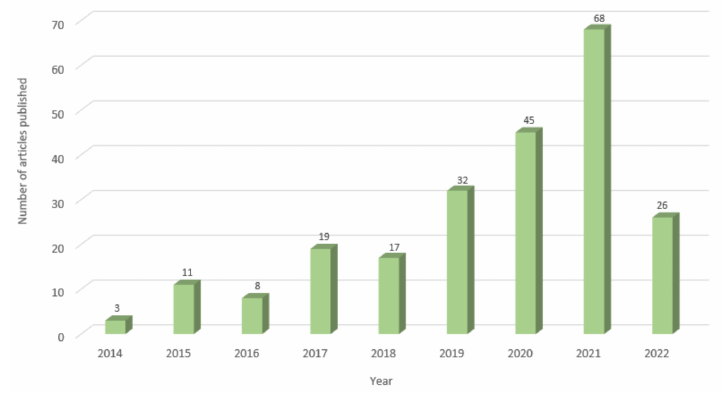
Figure 2. Annual scientific production (from 1 January 2014, until 24 July 2022).